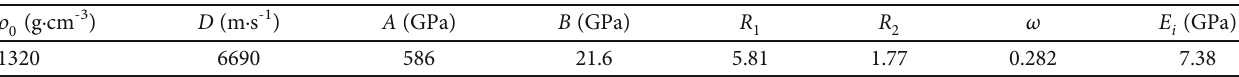
Figure 3: Curve fi tting on growth rates of strain rate: (a) dynamic compression (data from Zhang and Zhao [27]); (b) dynamic tension (data from Zhang and Zhao [27]). Table 1: Properties of explosive and JWL